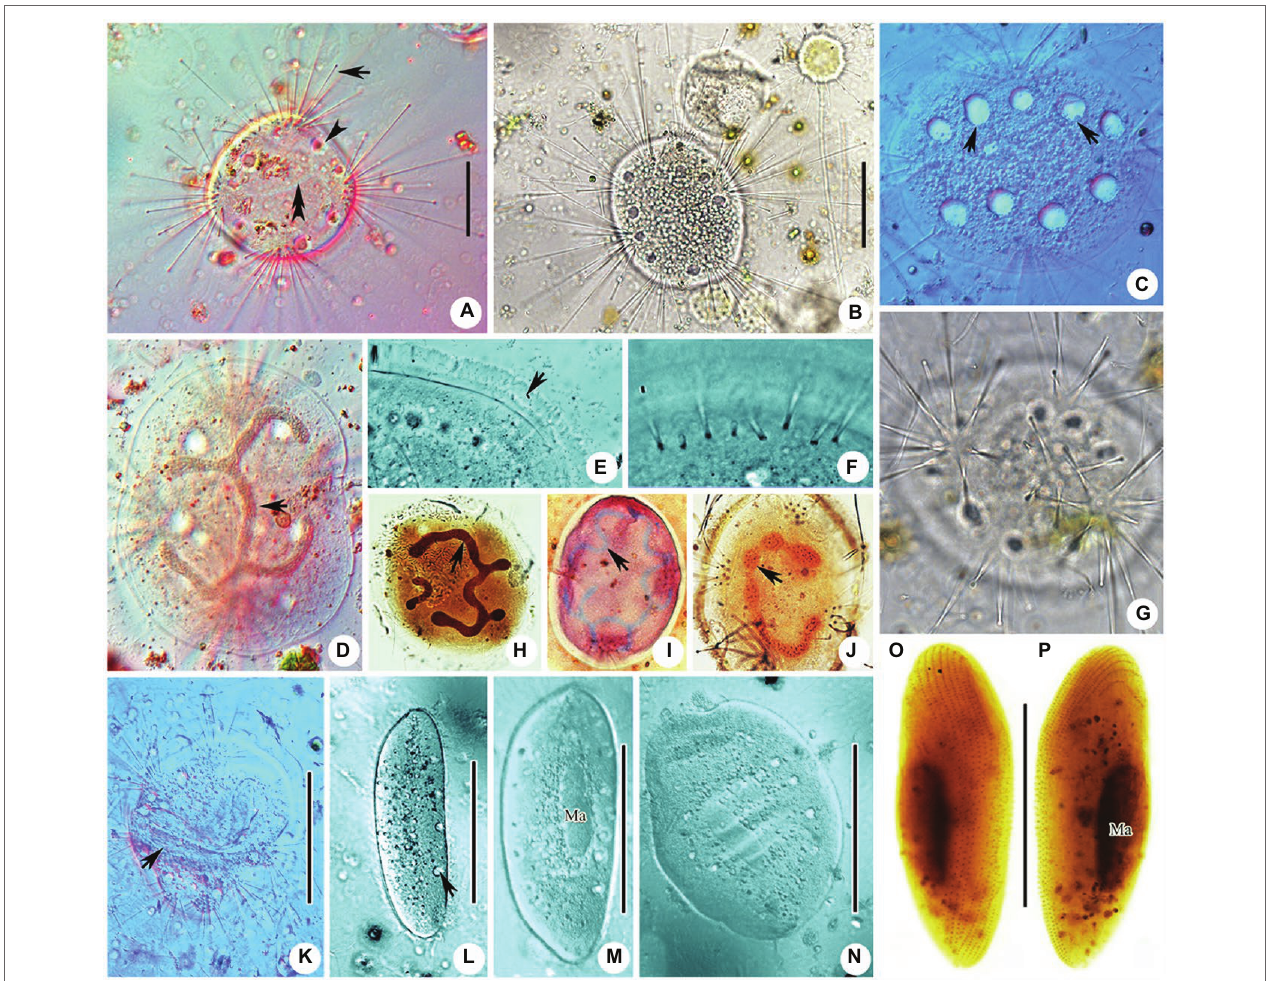
FIGURE 3 | Photomicrographs of Cyclophrya magna Gönnert, 1935 and its swarmer from life (A–G,K–N) and after protargol staining (H,J,O,P) as well as Methyl Green-Pyronin Staining (I) . (A) Cyclophrya magna in vivo . Arrow to show the tentacles. Arrowhead to show contractile vacuole. Double arrowheads to show macronucleus. (B–D,G) To show the different individuals with different number of tentacle fascicles and contractile vacuoles. Arrows in (C) show the contractile vacuoles. Arrow in (D) to indicate macronucleus in vivo . (E) The part of living trophont. Arrow protruding adhesive disc (ring). (F) To show tentacle fascicle. Some tentacles arranged in rows. (H–J) After protargol staining (H,J) and Methyl Green-Pyronin Staining (I) , arrows to show different shapes of macronucleus. (K) View of an individual during reproduction, arrow to indicate the swarmer. (L–N) The process from swarmer growing into trophont. Arrow in (L) to indicate contractile vacuole. (O,P) View of swarmer after protargol staining. Ma, macronucleus. Scale bars = 50 μ